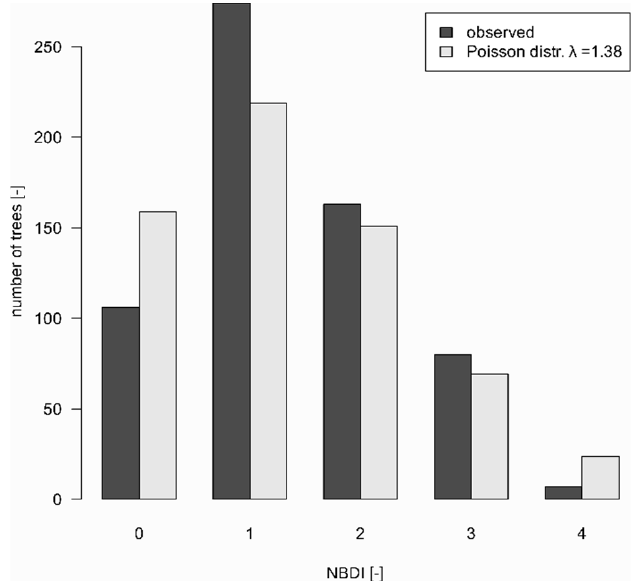
Figure 1. Tree numbers observed (black bars) and calculated from the Poisson distribution (grey bars, λ = 1.38) with {0..4} damage instances.